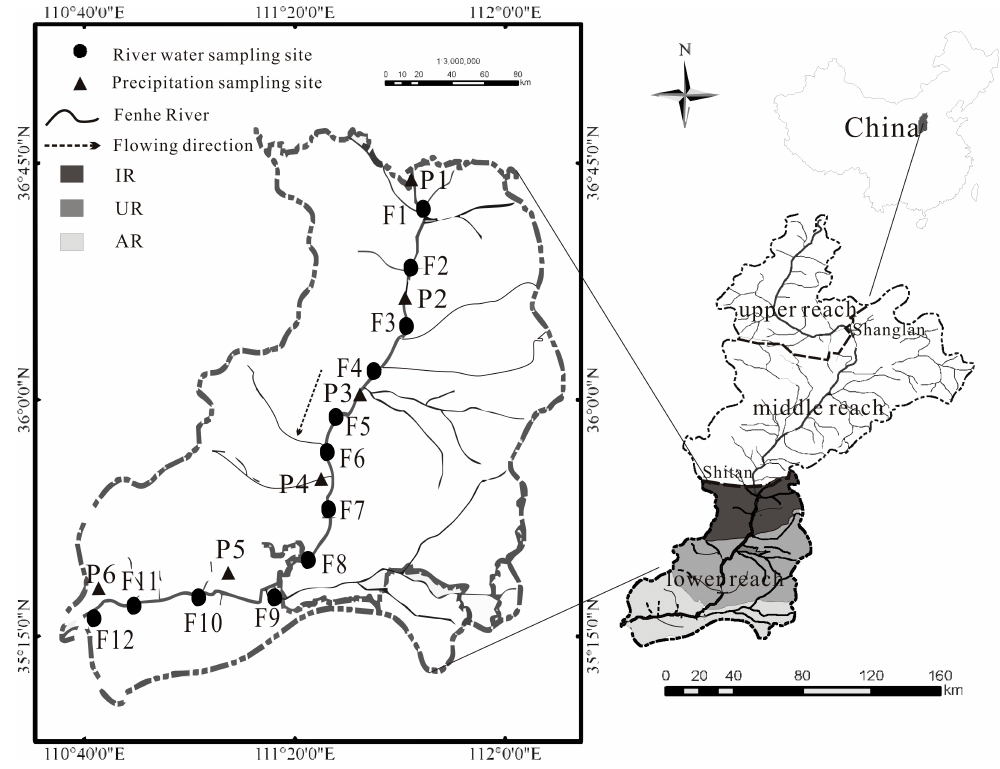
Figure 1. Location of lower reach of Fenhe River and sampling sites. IR: industrial region; UR: urban region; AR: agricultural region.